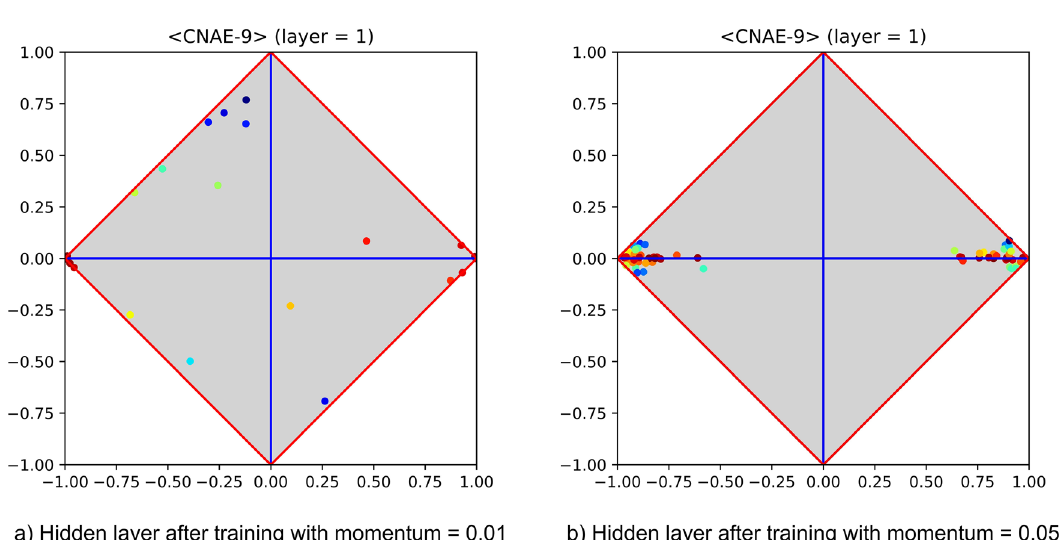
Figure 4. Depicting the hidden layer of an MLP trained with different values of momentum on the CNAE-9 dataset (from UCI). In particular, the hidden layer at the left-hand side shows that the MLP has been able to generalise, despite the fact that some neurons (i.e., those located at the left- and right-hand corners) operate in saturation, whereas the other highlights a clear pattern of failure, as all neurons operate in